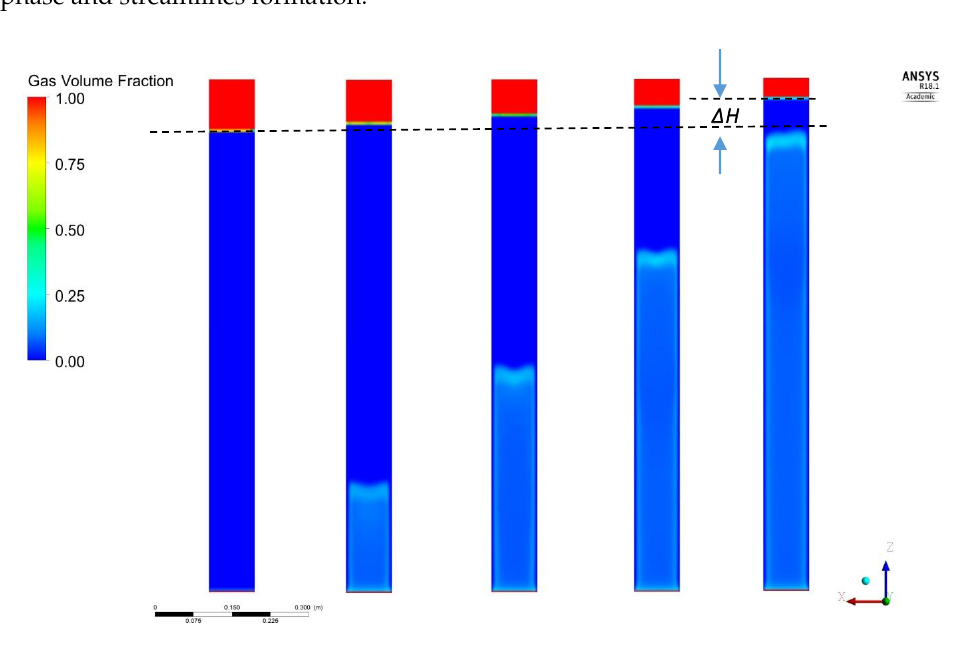
Figure 9. Bed expansion ( ∆ H) for different time snapshots: t = 0, 0.8, 1.6, 2.4 and 3.2 s (air-water, U GS = 0.2 m/s, d p = 40 µ m, d c = 9 cm) .